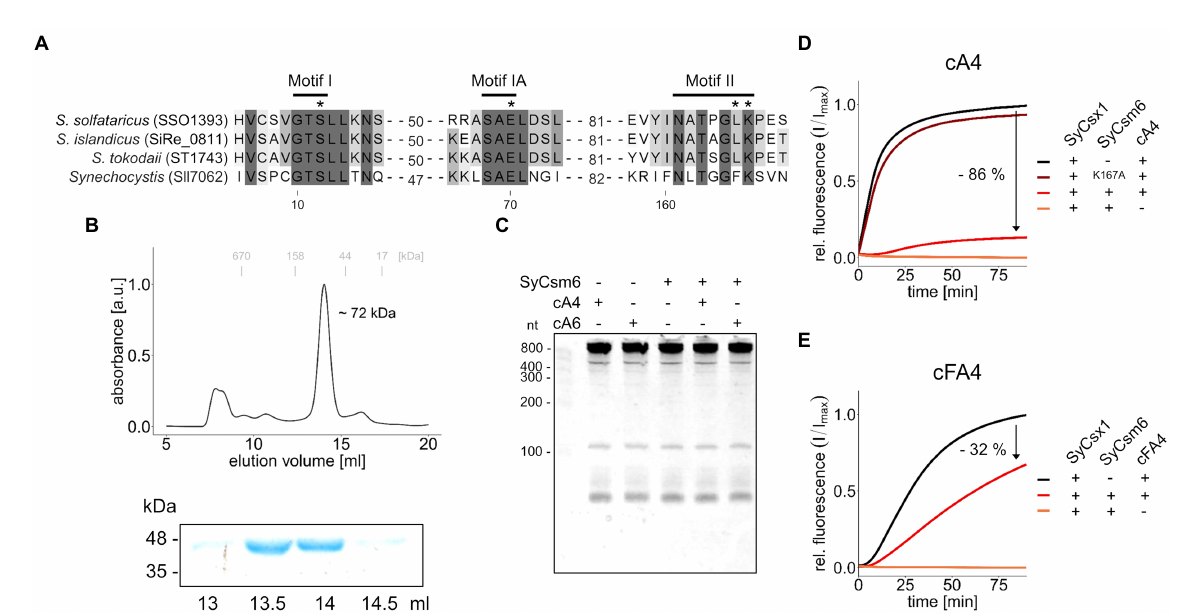
FIGURE 4 SyCsm6 has ring-nuclease activity but does not cleave RNA in vitro . (A) Multiple sequence alignment of SyCsm6 (Sll7062) and homologous Csm6/ Crn1 proteins showing conserved CARF domain motives implicated in cOA-binding and cleavage. An asterisk marks residues that were shown or predicted to impact ring nuclease activity. (B) His-tagged SyCsm6 (43.5 kDa) was isolated from E. coli by affinity chromatography and further purified by size-exclusion chromatography on a Superdex 200 10/300 column (upper panel). Elution fractions were analyzed by SDS-PAGE (lower panel, see Supplementary Figure S1). (C) 400 ng of Synechocystis total RNA were incubated in the presence or absence of SyCsm6 and 300 nM cOAs for 1 h and subsequently separated on a 12% denaturing PAA gel. (D) A fluorogenic ribonuclease activity assay measuring RNA cleavage by SyCsx1 after pre-treatment of 30 pmol cA4 with either wild-type SyCsm6, the putatively inactive K167A variant, or a control without protein. After the pre-treatment for 60 min at 30 ° C and inactivation of SyCsm6 by heating to 95 ° C for 5 min, the reaction was started by adding SyCsx1 and 20 n m RNaseAlert substrate (excitation 490 nm; emission 520 nm). (E) The same assay as before using tetrafluoro-c-tetraAMP (cFA4) as the substrate. All fluorogenic assays were performed in triplicates and mean values of relative fluorescence normalized to the maximum substrate turnover are